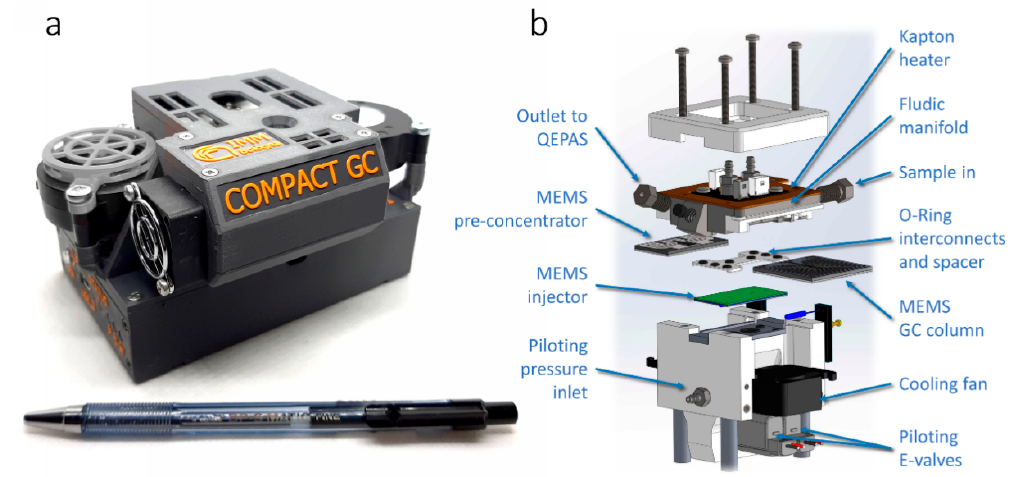
Figure 3. Compact-GC prototype ( a ) and rendering of core components ( b ). Table 2. Working parameters of the Compact-GC